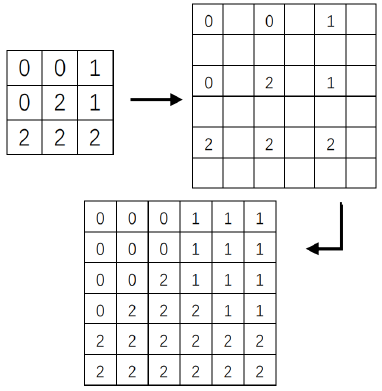
Figure 1. From downscaling to original scale classification.